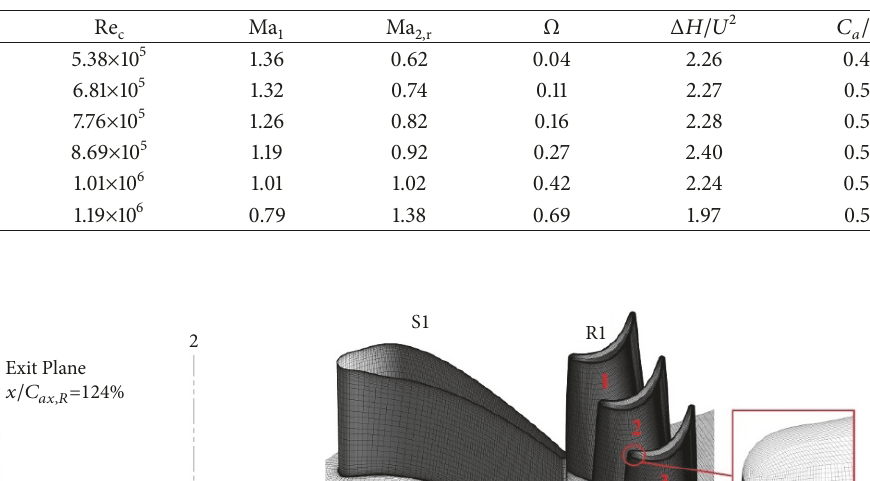
Table 2: Operating conditions for VGT with nominal pressure ratio.